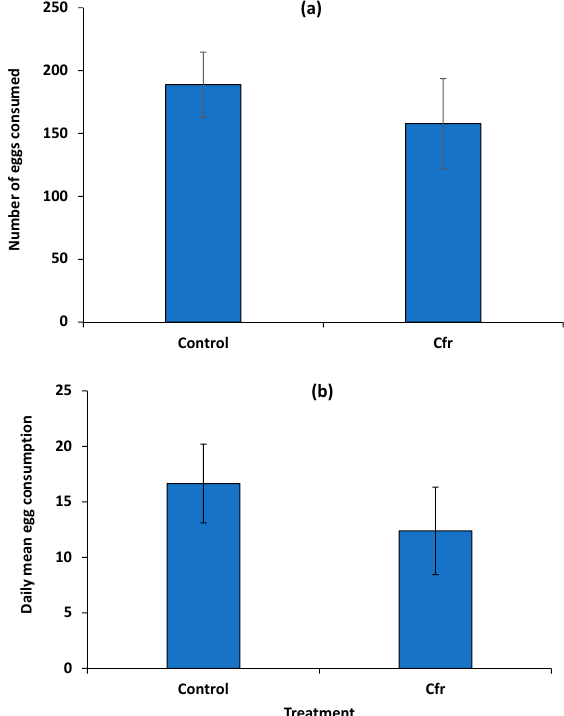
Figure 3. Total number ( ± SEM) of Aleurothrixus trachoides eggs consumed ( a ) and daily mean ( ± SEM) consumption rate ( b ) by an adult Delphastus catalinae beetle after being treated with either Cordyceps fumosorosea (Cfr) or water (control) on leaves of red missile ornamental plants for 24 h. The daily mean egg consumption or consumption rate by the adult beetle was not significantly different between treatments (Student’s t -test, p > 0.05).